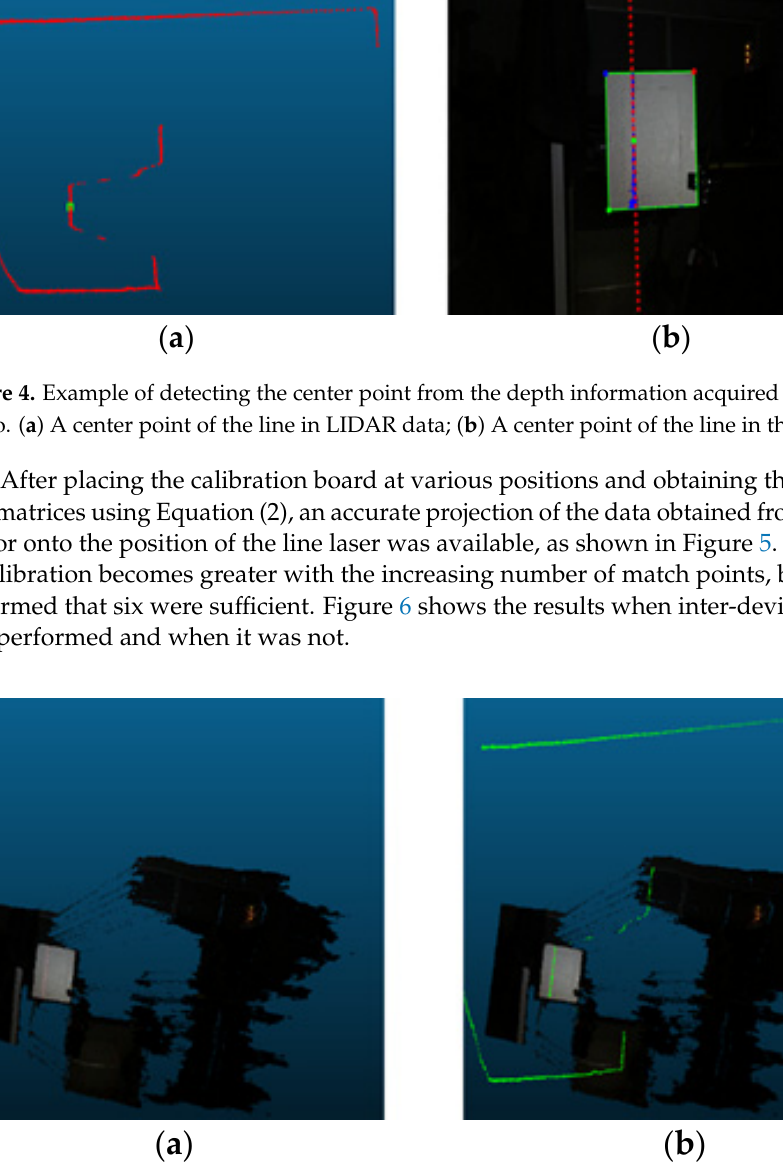
Figure 5. The result of calibrating the LIDAR and stereo camera using the center points. ( a ) 3D point cloud obtained from the stereo camera; ( b ) The result of superimposing the information scanned from the LIDAR on the stereo 3D point cloud. three-dimensional depth information expressed in one coordinate system. In this study, the reference coordinate system of the device was defined as the stereo camera’s coordinate